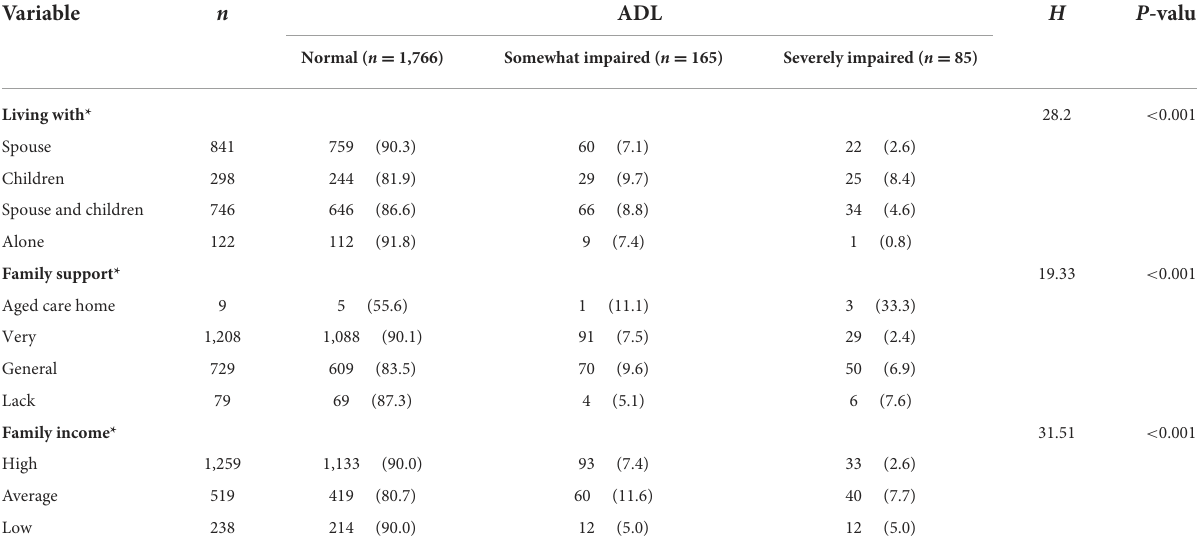
TABLE 4 Comparison of activities of daily living (ADL) functions by family characteristics in older people with type 2 diabetes in Fuzhou. Variable